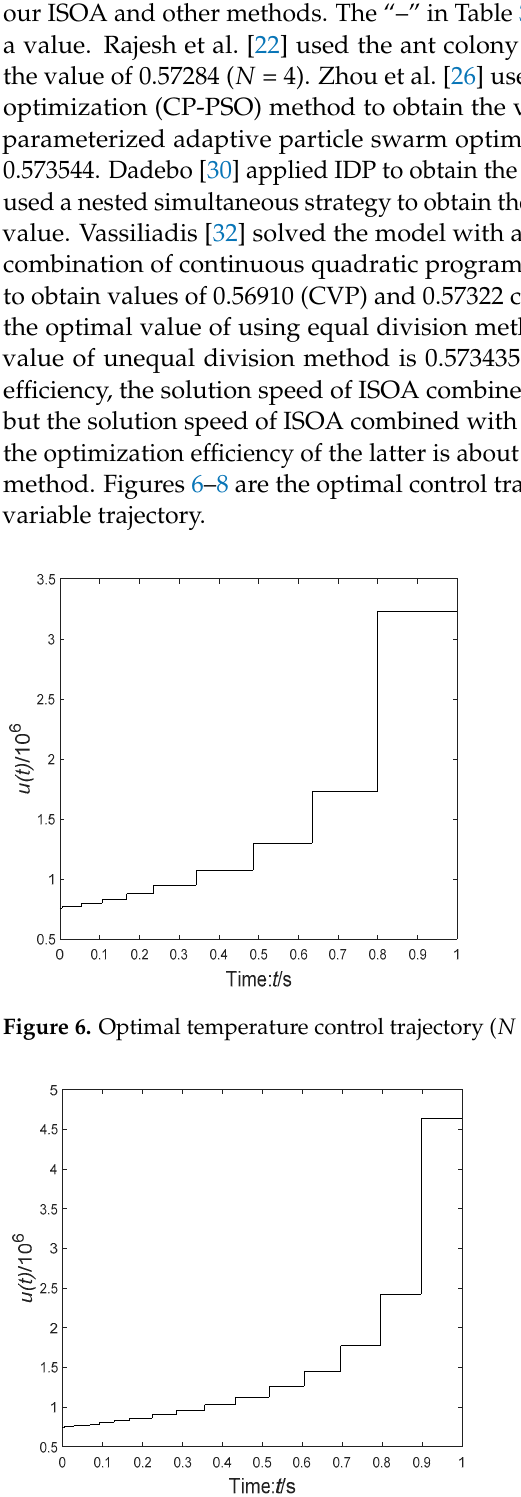
Figure 8. Optimal temperature control trajectory ( N = 40). Figure 9. Optimal trajectory of state variables. 5.5. Case 3: Tubular Reactor The tubular reactor was proposed by some authors [34,35]. The reaction process is as follows: in a certain length of pipeline, the catalysts A and B are mixed, and the target product C is produced after the reaction is completed. The goal of the problem is to distribute the catalyst in the designated pipeline so that the concentration of the target product C reaches the optimal value. The mathematical model of the tubular reactor problem is as follows: